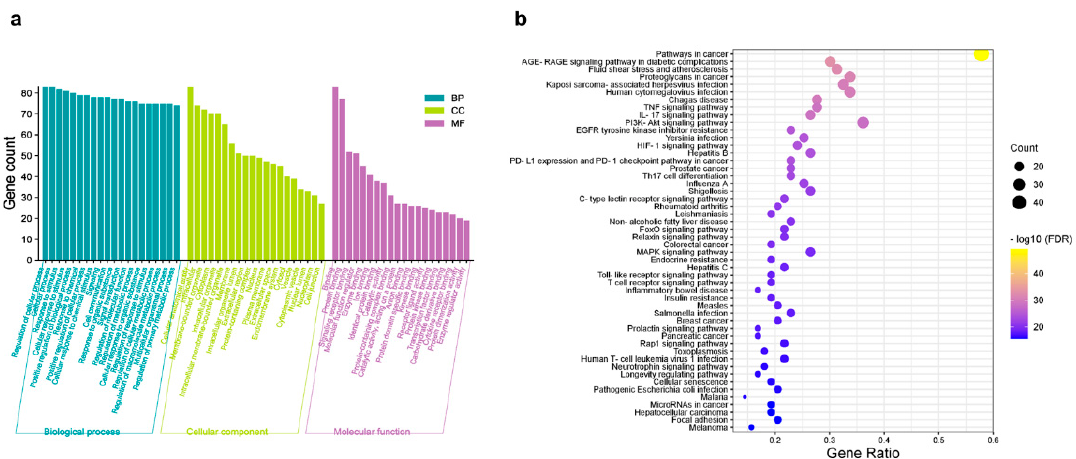
Figure 3. Enrichment analysis of potential targets. ( a ) GO function enrichment; ( b ) KEGG function enrichment.